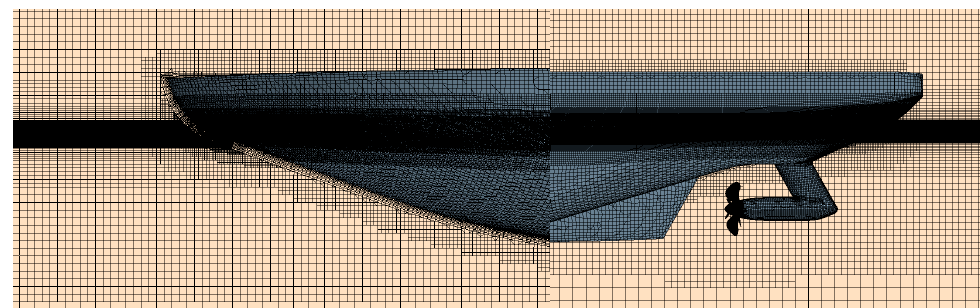
Figure 2. Model of the self-propelled ship.